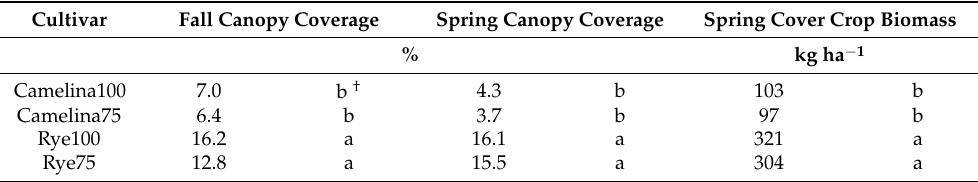
Table 8. Mean fall and spring canopy coverage and cover crop biomass for cover crops across four environments in Fargo, ND, USA, from 2016, 2017, and